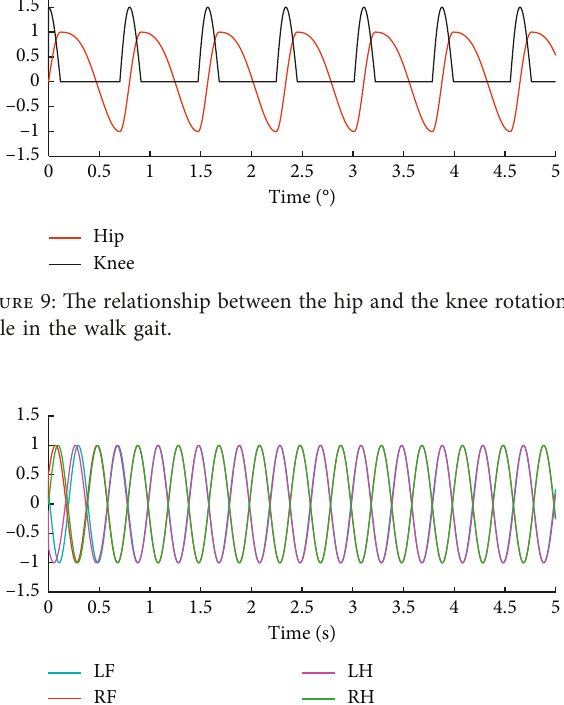
Figure 10: Phase relationship of the hip joint in the trot gait.